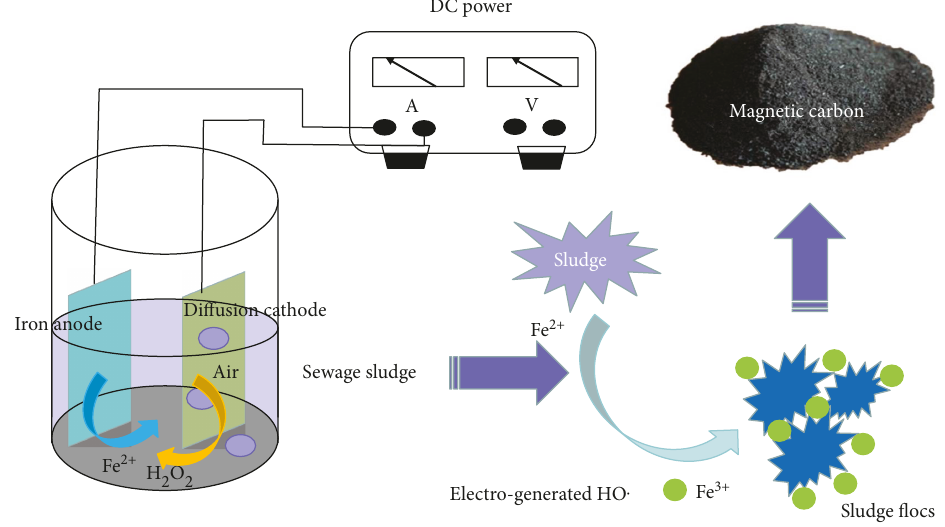
Figure 3: The preparation of EF-SBAC